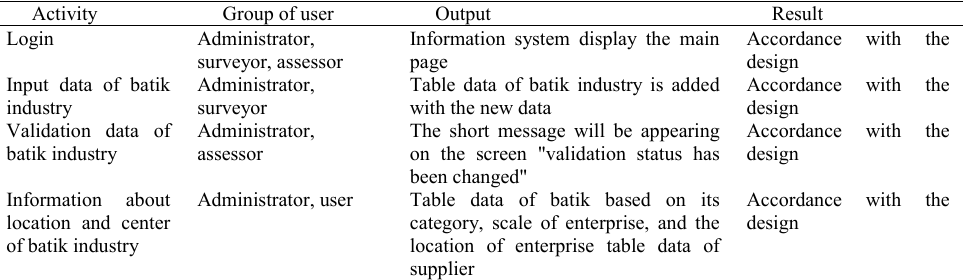
Accordance with the